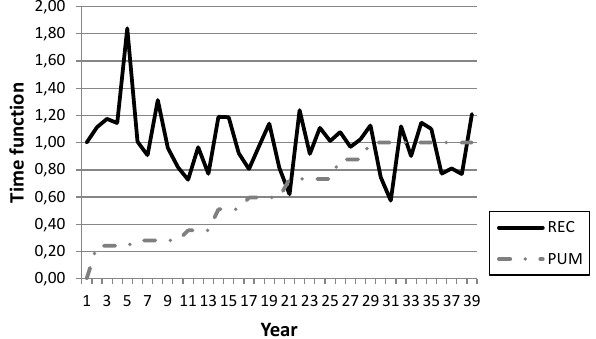
Fig. 5. Time function for recharge and pumping applied to the tran- sient